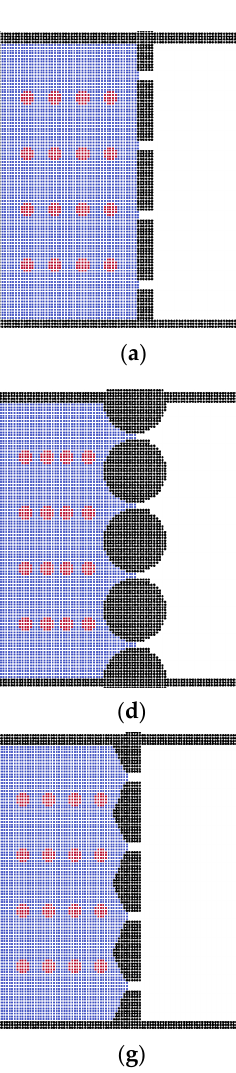
( l ) Step = 200 Figure 7. The different oil droplet size systems in membrane for the oil–water separation, ( a , b , e , f , i , j ) forming oil droplets with radii of 4 μ m; ( c , d , g , h , k , l ) forming oil droplets with radii of 8 μ m. To examine the effect of oil viscosity, as shown in Figure 8, oil droplets with different viscosities were examined. As we discussed, the oil particles would remain in the corner of the system because there was less surface energy. Thus, the residual oil particles always stayed in the same place. In the membrane system with higher oil viscosity, the oil parti- cles tended to adsorb on the membrane surface. ( a ) ( c ) Figure 8. Results of separation with different oil viscosities: ( a ) 0.2 mPa·s; ( b ) 0.4 mPa·s; ( c ) 0.8 mPa·s.